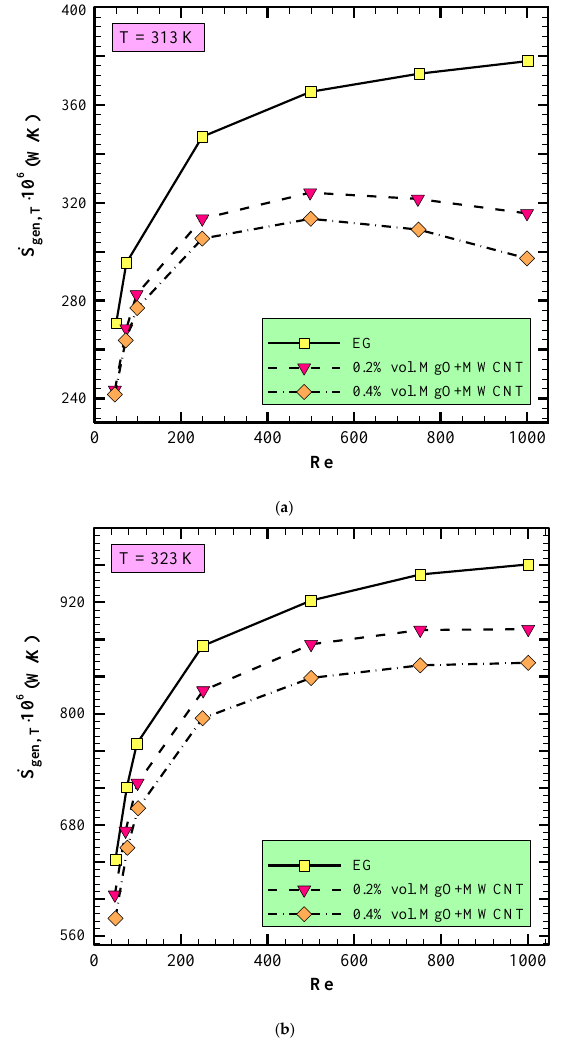
Figure 16. Effects of HNF with different VF on thermal entropy generation for different Re and inlet temperatures of ( a ) T = 313 K and ( b ) T = 323 K.